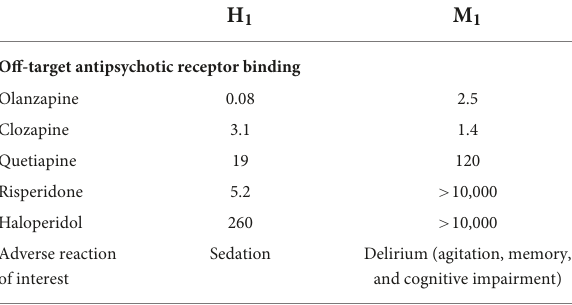
TABLE 1 Data are represented by the equilibrium constant